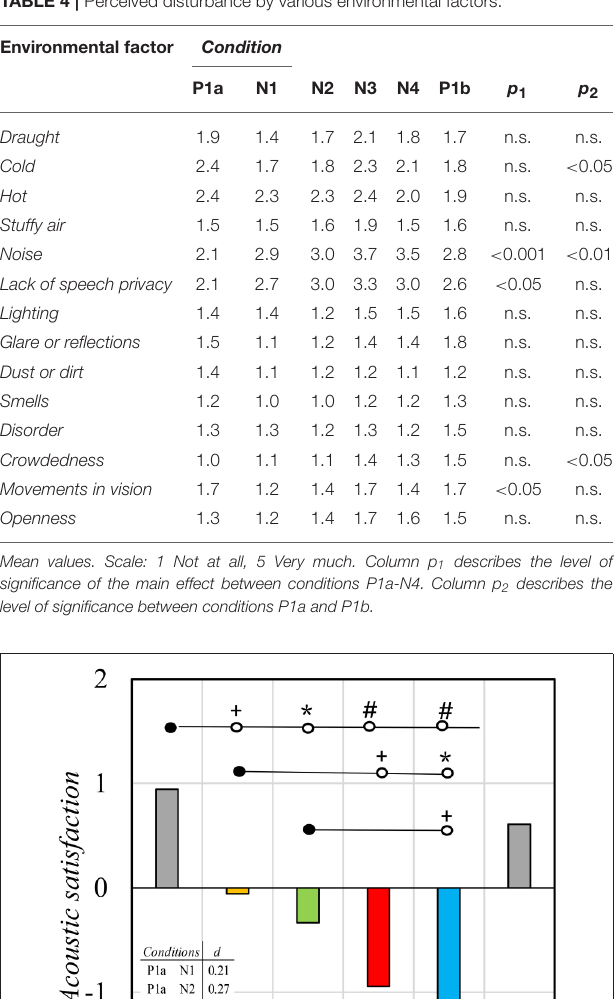
TABLE 5 | The perceived disturbance of work by different sound sources.